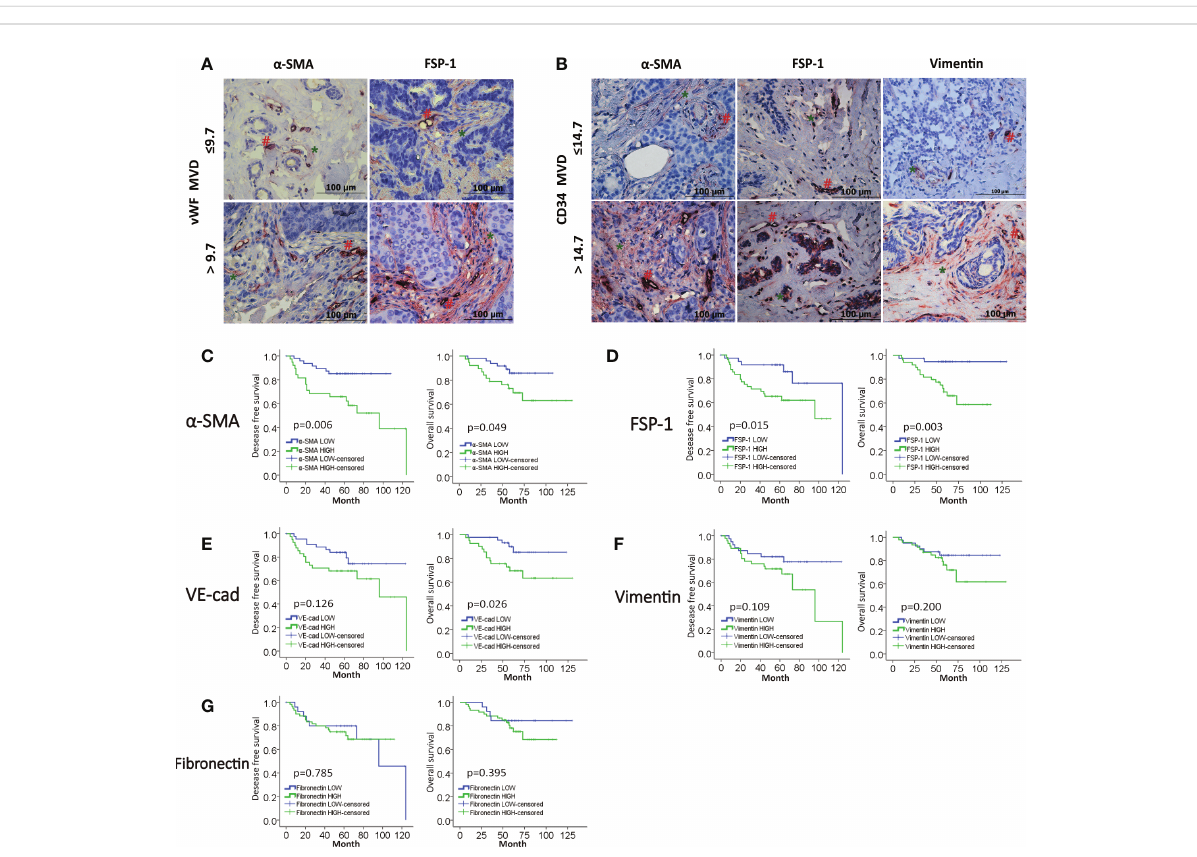
FIGURE 2 MVD level is positively correlated with EndMT markers in breast cancer. (A, B) Representative images of double-IHC staining of vWF, CD34 (brown, with red “ # ” ) and either a -SMA, FSP-1 or Vimentin (red, with green “ * ” ) in samples from IDC patients. (C – G) Kaplan-Meier analysis of DFS and OS of IDC patients from our cohort by a -SMA, FSP-1, Vimentin, VE-Cadherin and